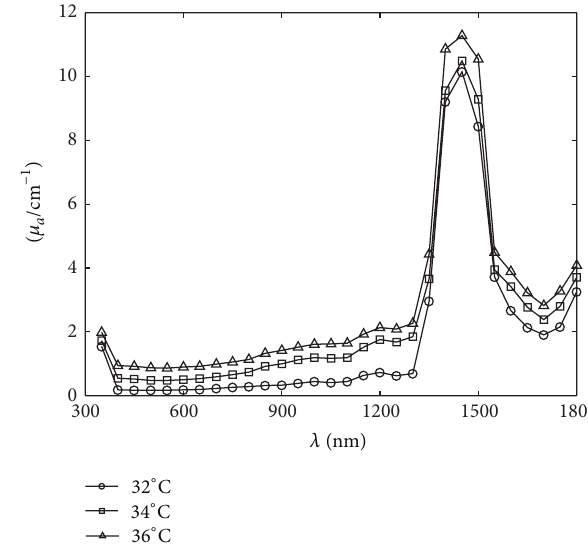
Figure 3: The spectral scattering coefficients of the thermotropic material at 32, 34, and 36 ∘ C, respectively.